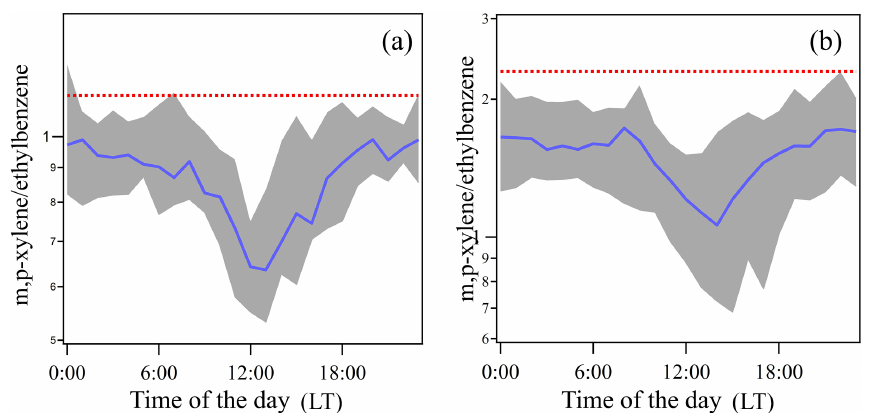
Figure 7. Ratios ofm,p-xylene to ethylbenzene in Beijing in 2013 (a) and Heshan in 2014 (b) . Red dotted line: the highestm,p- xylene to ethylbenzene ratio, assumed as emission ratios ofm,p-xylene to ethylbenzene, 1.15ppbVppbV − 1 in Beijing in 2013 (a) and 2.3ppbVppbV − 1 in Heshan in 2014 (b) . Shaded regions indicate the standard deviation for the ratios during the campaign average.